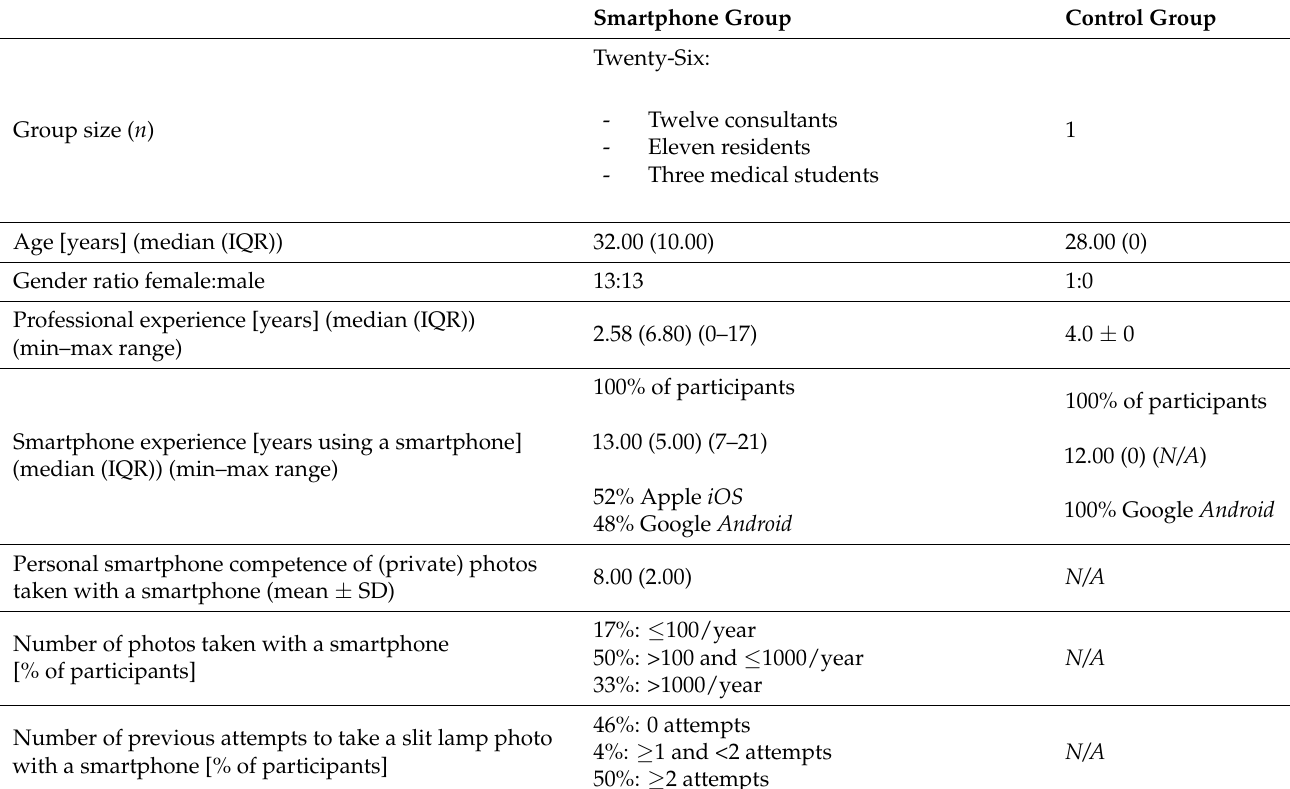
Table 1. Demographic data. Smartphone Group Control